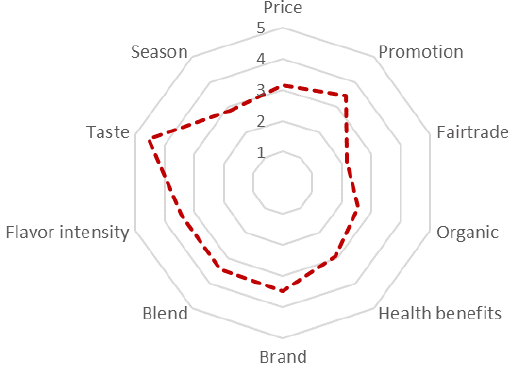
Figure 8. Yerba mate purchasing driving factors.